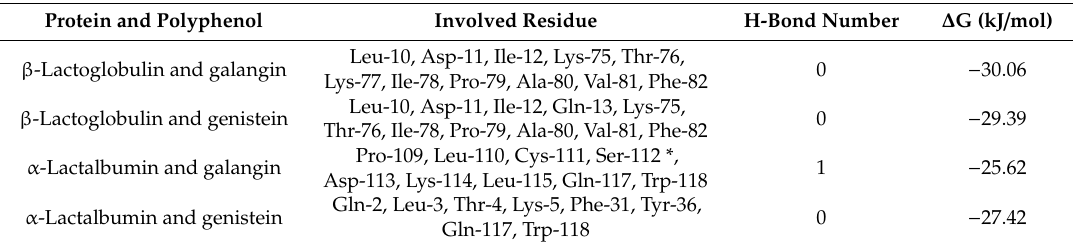
Table 6. The amino acid residues, H-bond number, and interaction energy ∆ G values involved in the non-covalent interaction of galangin / genistein with β -lactoglobulin / α